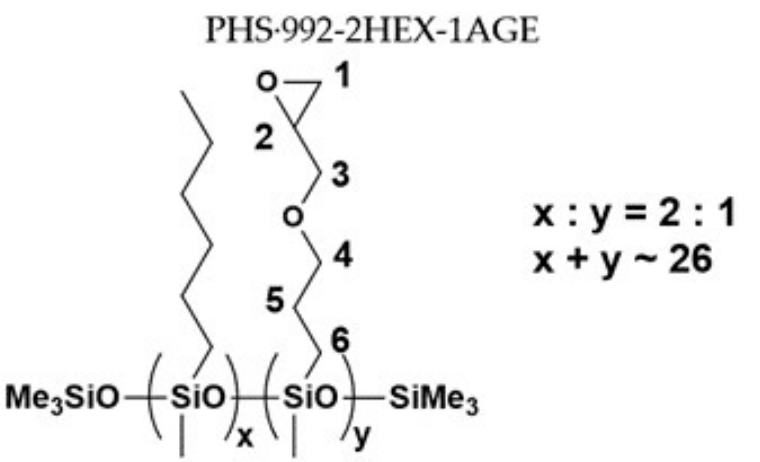
Scheme 2. The scheme of the structure of the MFSC 2 modifier.